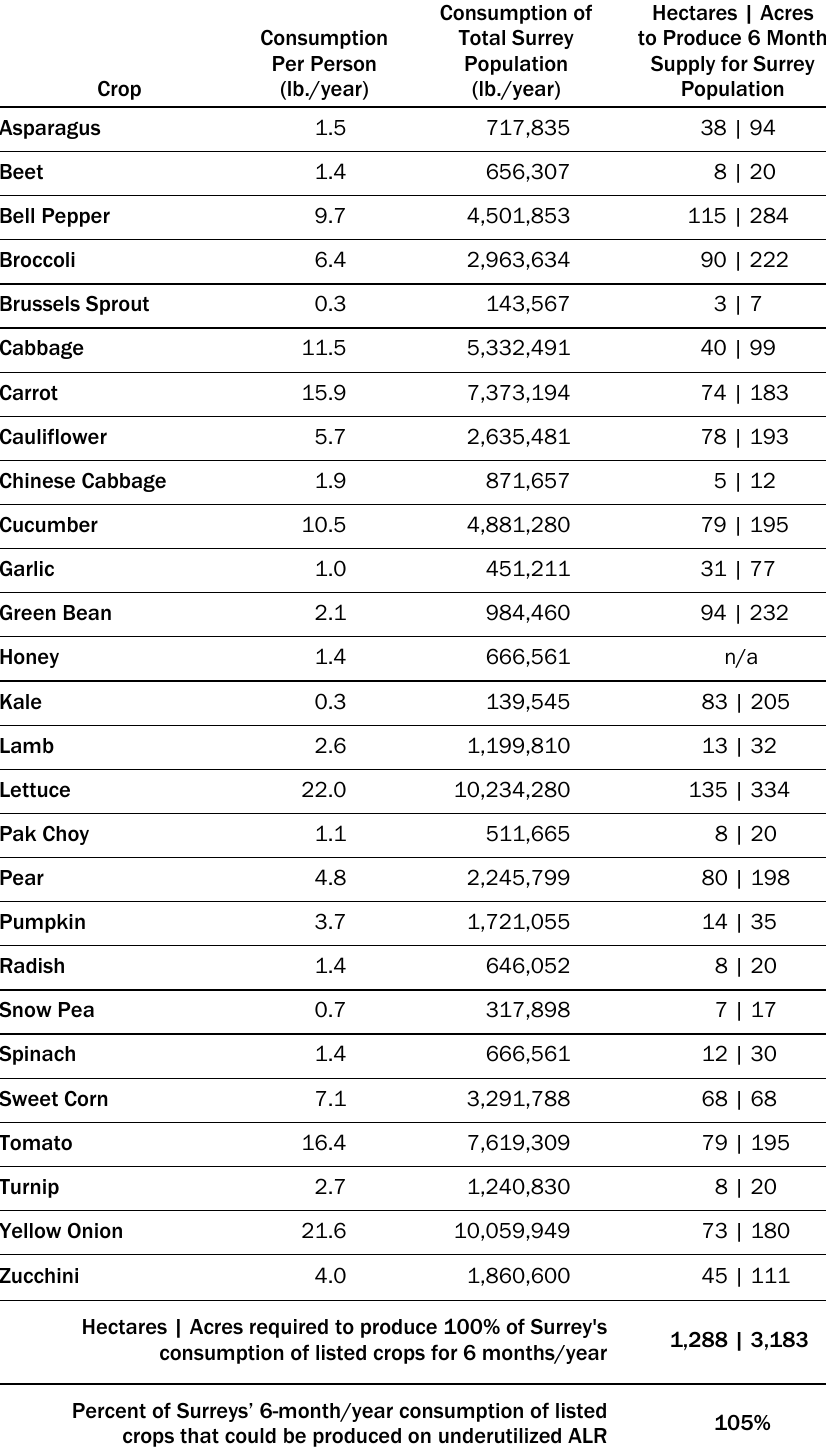
Table 6. Land Needed to Satisfy Consumption Rates for Population of Surrey,